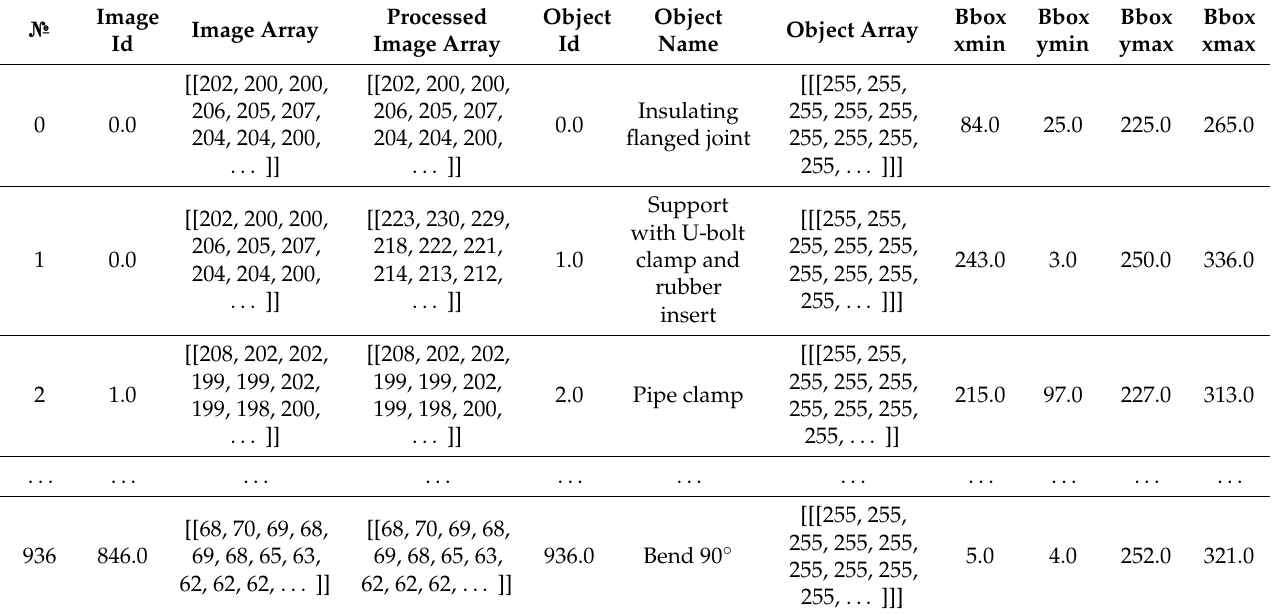
Table 7. Database fragment.